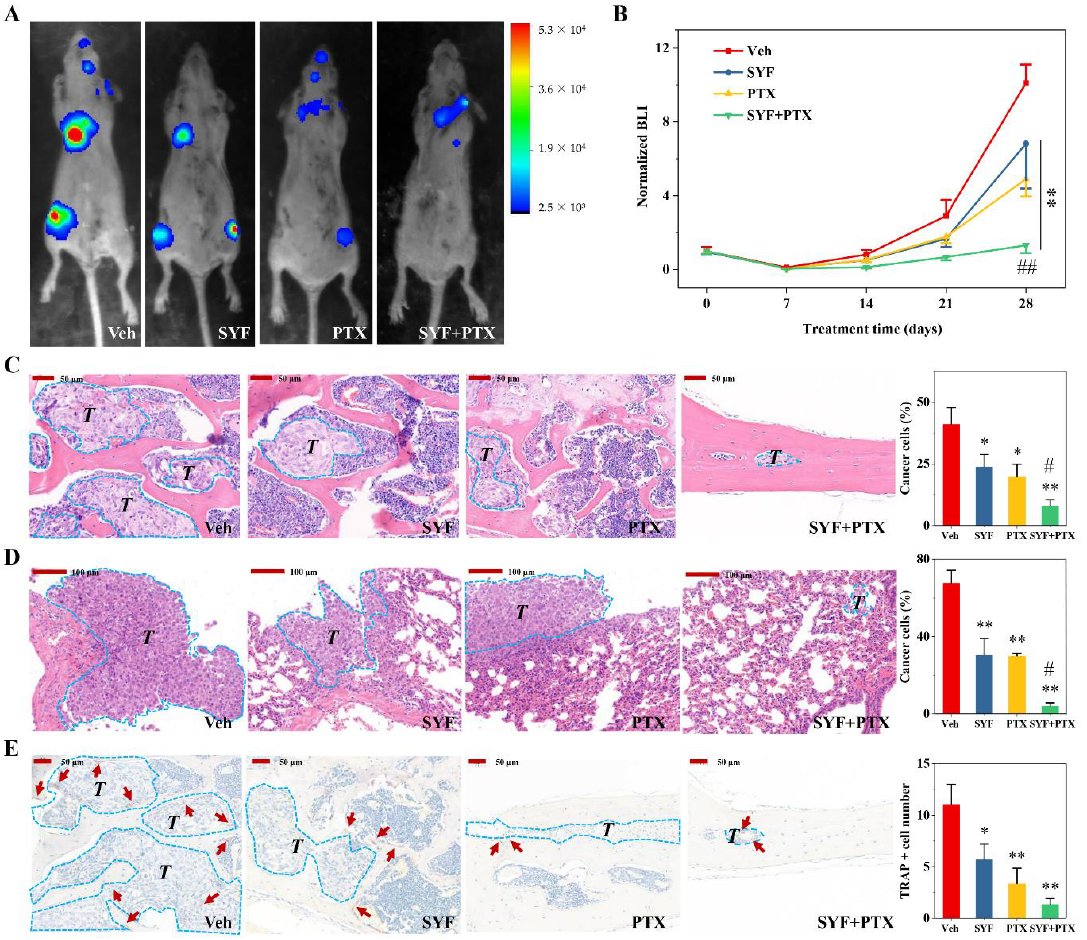
Figure 6. SYF reduced breast cancer cell metastasis in vivo. ( A ) SYF significantly reduced tumour cell metastasis in tumour-bearing mice. Tumour metastasis was achieved in mice by injection of breast cancer cells (1 × 10 6 cells/mouse) into the left ventricle. SYF or vehicle was then administered daily, and paclitaxel was administered via intraperitoneal injection twice a week for 4 weeks (N = 6). In vivo BLI with a luciferase reporter was performed at the indicated times to assess the extent of tumour metastasis. ( B ) Normalized BLI signals. ( C ) Representative photographs of HE staining and quantitative analysis of tumour proportions in bone. ( D ) Representative photographs of HE staining and quantitative analysis of tumour proportions in lung metastases. ( E ) Representative photographs of TRAP staining and quantitative analysis of TRAP + cells in bone. TRAP + cells are marked with red arrows. Tumour metastases are marked with rose red dotted lines and the letter T . * p < 0.05, ** p < 0.01 vs. Veh group. # p < 0.05, ## p < 0.01 vs. PTX group.